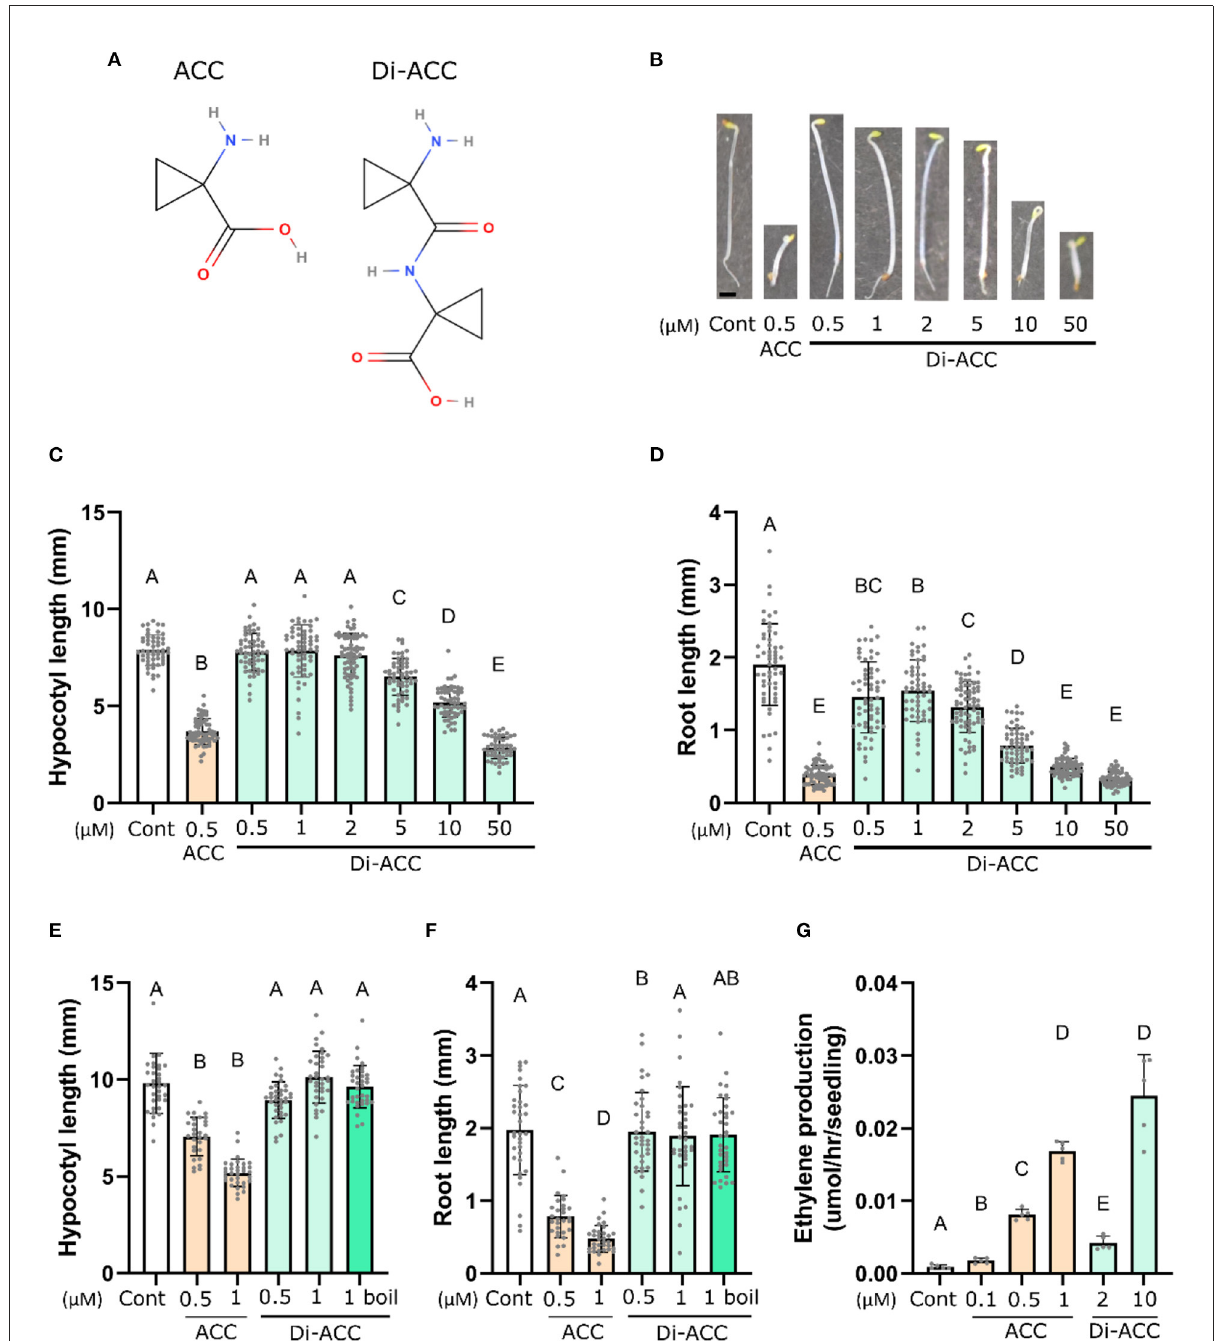
FIGURE1 ACC dimer induces the triple response phenotype in Arabidopsis. (A) The molecular structures of ACC and its dipeptide di-ACC. (B) Representative images and (C,D) quantification of hypocotyl (C) and root length (D) of 4-day-old dark-grown seedlings grown on medium containing ACC or di-ACC ( n ≥ 54). (E,F) Quantification of hypocotyl (E) and root length (F) in a triple response assays after boiling di-ACC for 1h prior to addition to the culture media ( n ≥ 29). (G) In planta ethylene production of 4-day-old dark-grown seedlings treated with ACC or di-ACC ( n = 5). Scale bar in (B) is